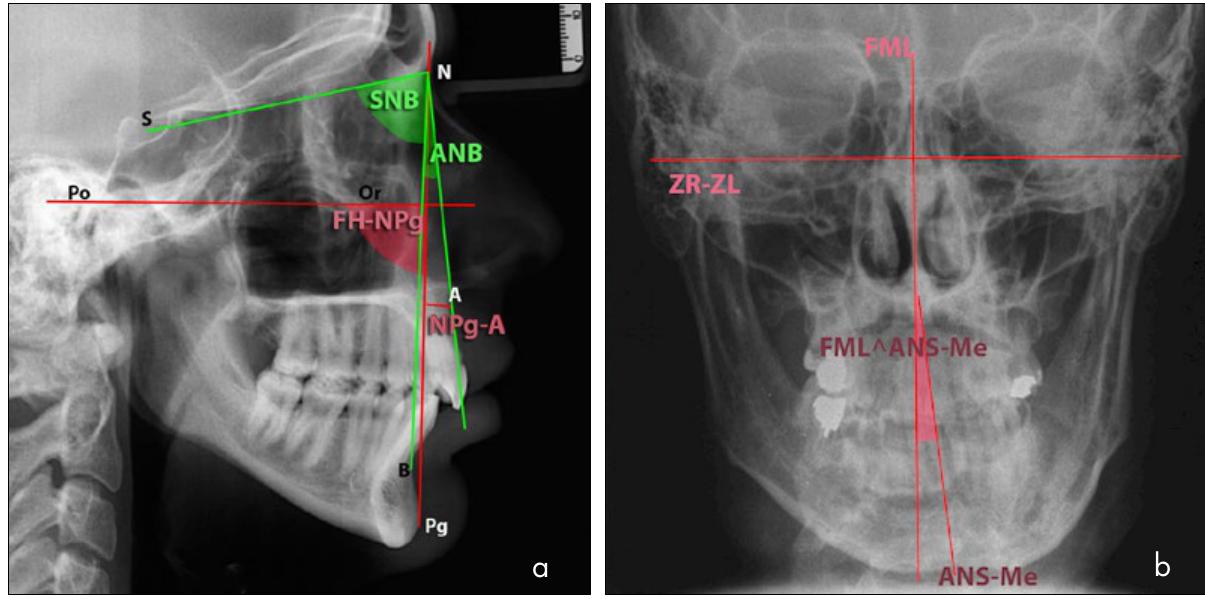
a b Figure 2. (a) Cephalometric measurements used for assessing the skeletal changes in Class II patients, (b) the posteroanterior cephalometric measurements used in asymmetric cases.